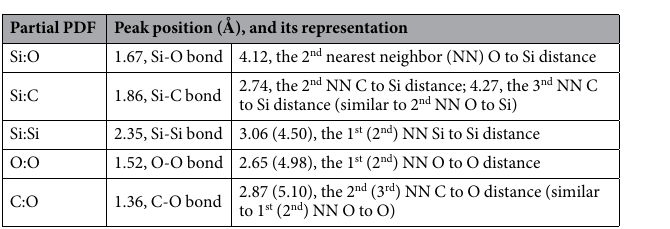
Partial PDF Peak position ( Å ), and its representation Si:O 1.67, Si-O bond 4.12, the 2 nd nearest neighbor (NN) O to Si distance